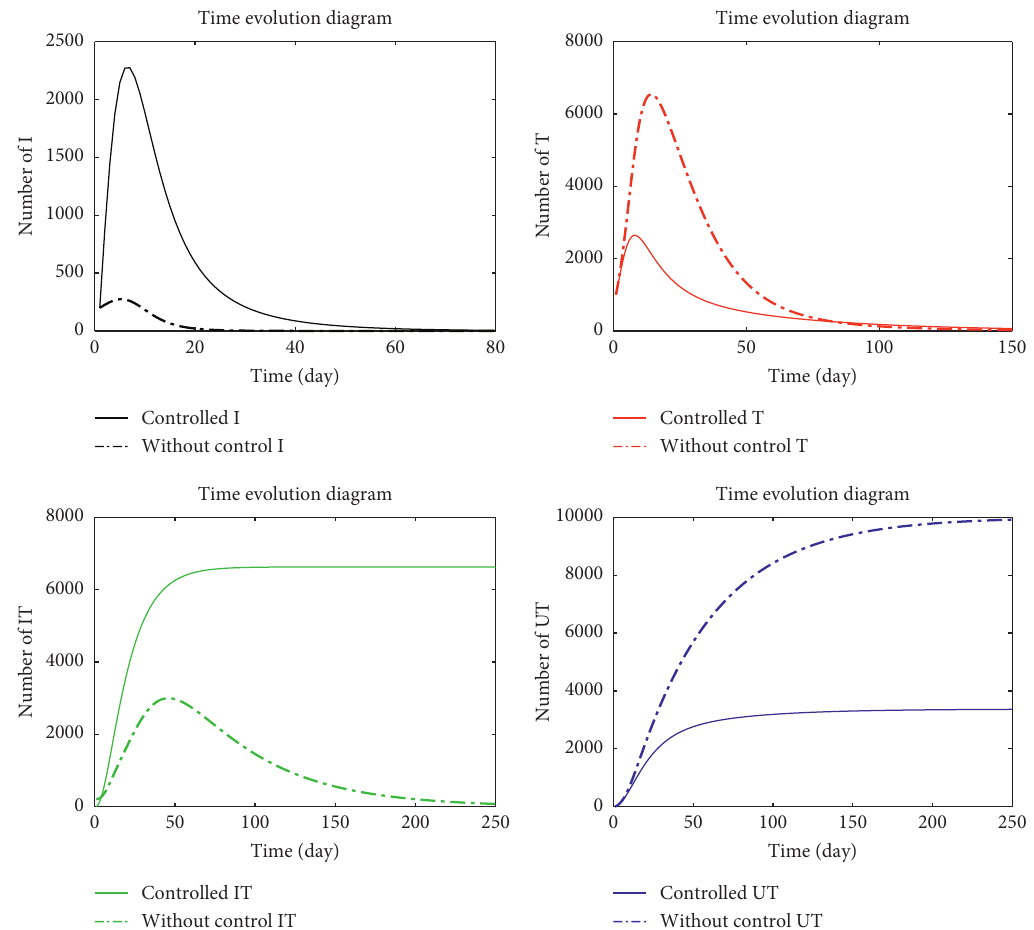
Figure 4: Time evolution graph of the number of nodes changing with and without